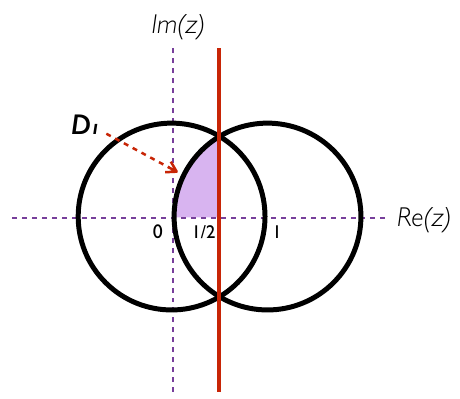
Figure 1. Integration in the ( z; (cid:22) z ) plane. The fundamental domain D 1 is the violet region. The regions D 2 ; D 3 and D 4 are de(cid:12)ned in (2.10) and are easily recognizable in the